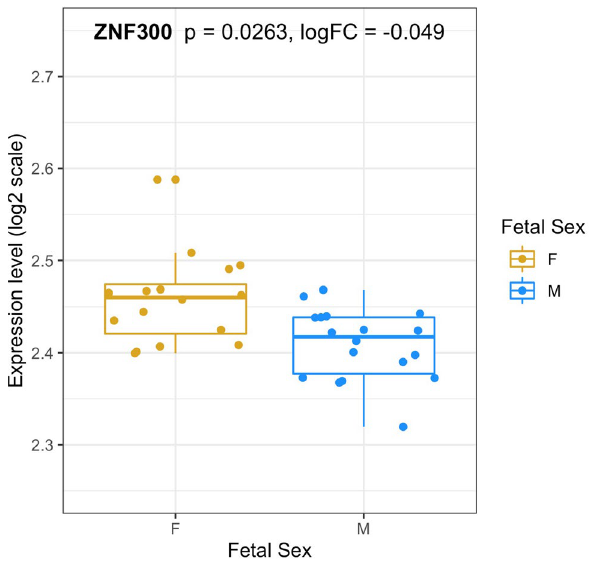
Figure 6. Placenta gene expression at ZNF300 Box plots of the distribution of ZNF300 gene expression (log2 scale) in males (blue) and females (gold) represented in the GSE75010